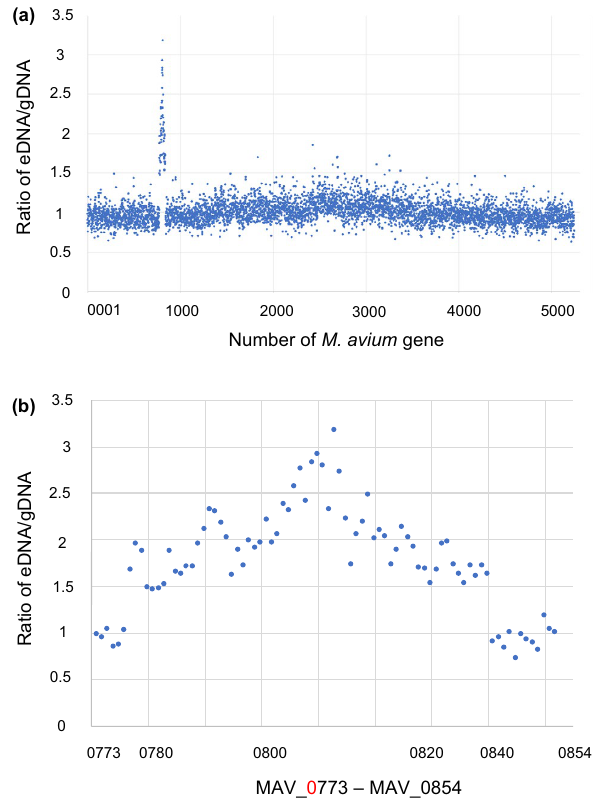
Figure 7. ratio of gDNA and eDNA of each gene in M. avium 104. ( a ) The abundance ratio of gDNA to eDNA in M. avium was calculated for each genes. ( b ) An expansion of (a) from MAV_0773 to